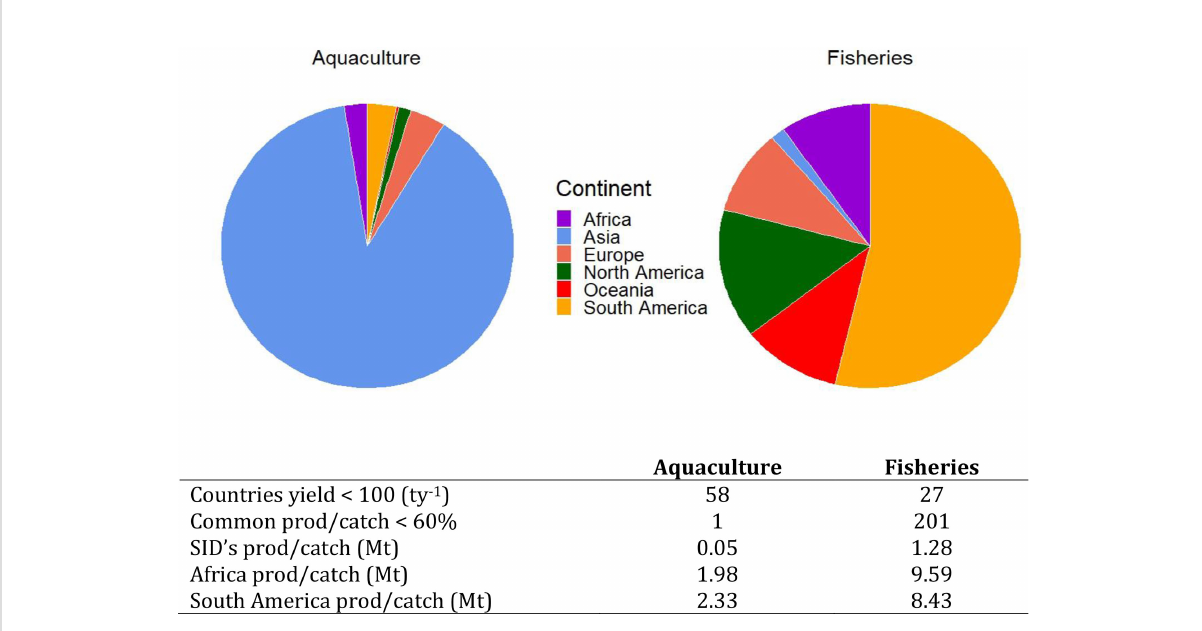
FIGURE 4 Global food fi sh production is unbalanced. The continental percentage contribution to global food fi sh production from aquaculture and fi sheries